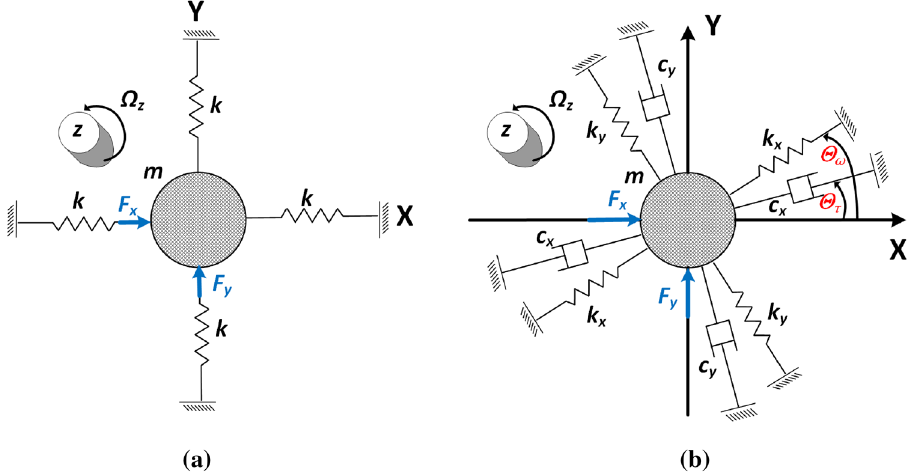
Figure 2. Comparison of ( a ) ideal HRG model and ( b ) HRG model with asymmetry components.